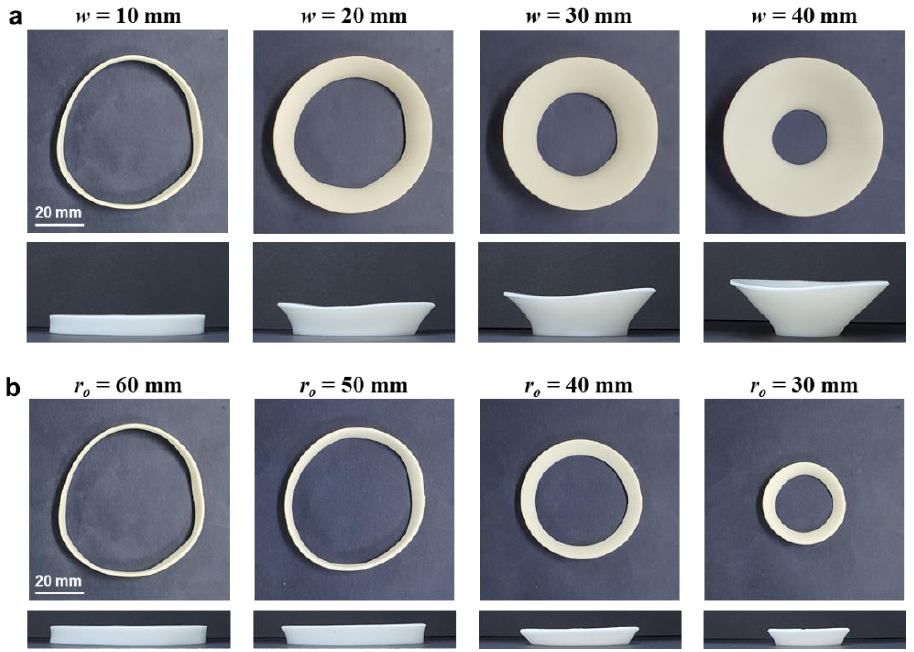
Figure 5. Thermal deformation results of the full annulus frame: ( a ) deformed shapes with various annulus widths ( r o = 60 mm); ( b ) deformed shapes with various outer radii ( w = 10 mm). Here, the top and front views are provided to show the three-dimensional shape transformation.